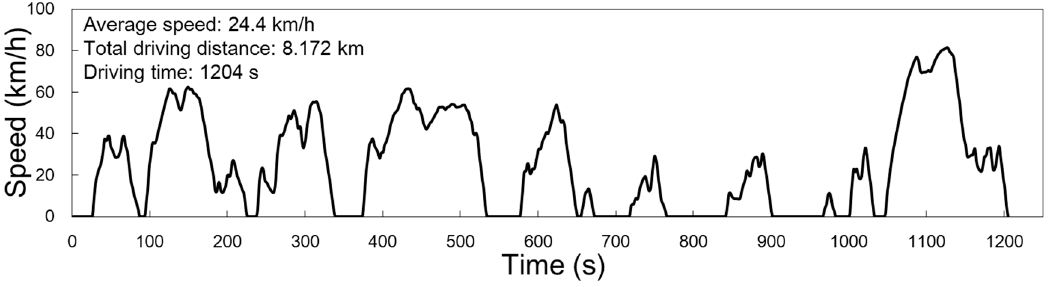
Figure A1. Summary of JC08 driving test mode, the approved vehicle test mode used in Japan until 2018. Table A1. Experimental setup for gas chromatography–flame ionization detection (GC-FID) used in this study.